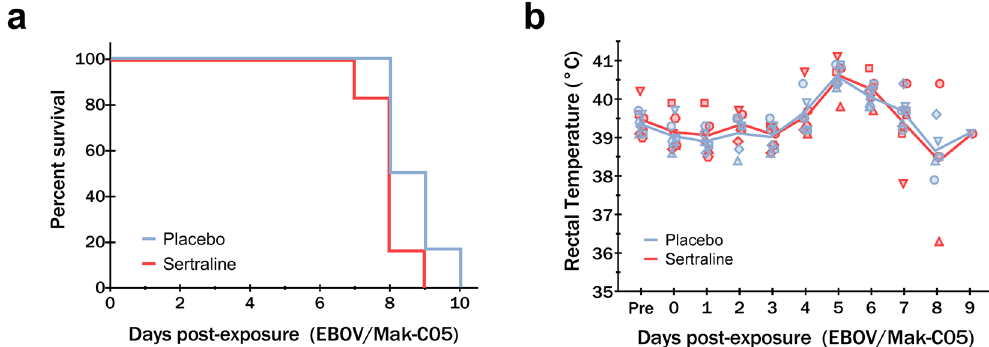
Figure 1. Survival analysis of sertraline and placebo treated animals exposed to a lethal dose of Ebola virus. Groups of 6 male rhesus macaques were treated with 200 mg sertraline hydrochloride (red) or placebo (blue) by orogastric tube daily beginning six days prior to intramuscular challenge with EBOV/Mak-C05. The survival analysis ( a ) shows a median time-to-disposition of 8 and 8.5 days for sertraline- and placebo-treated groups, respectively. Rectal temperatures ( b ) for sertraline hydrochloride and placebo treated animals were evaluated at each anesthetized